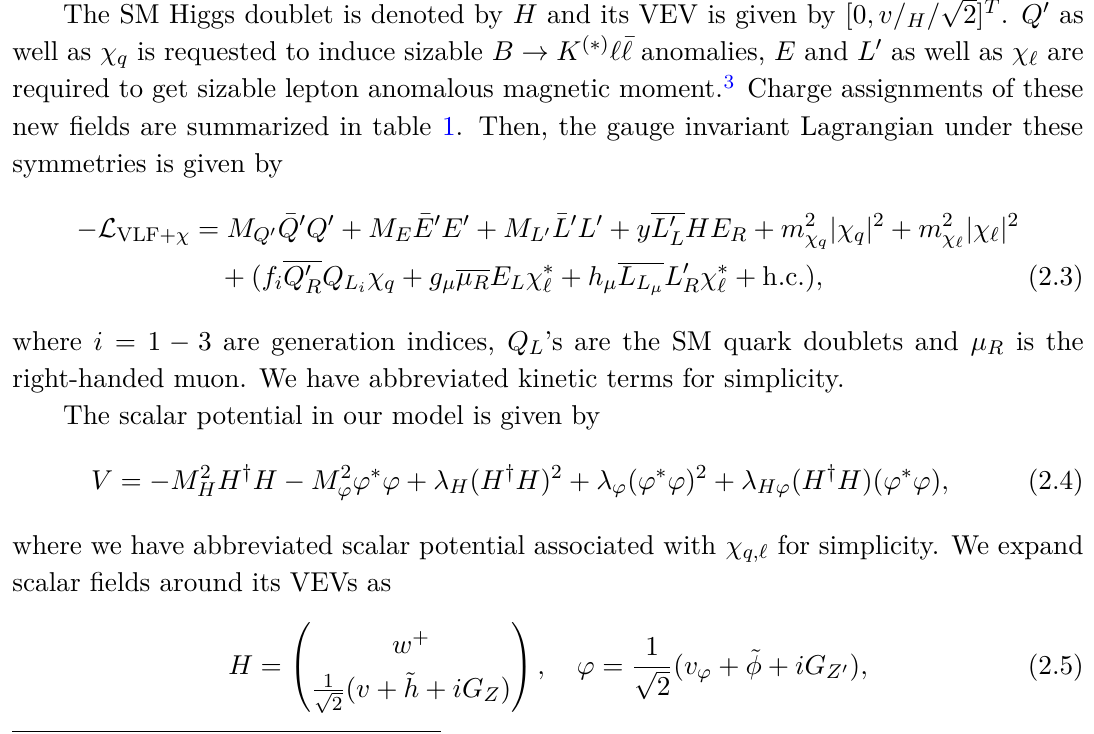
Figure 1 . The diagrams introducing effective coupling for Z 0 F µν ¯ bσ µν P L,R s + h.c.